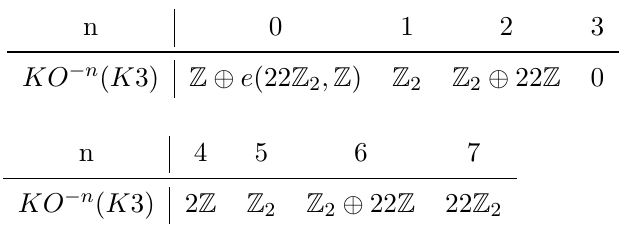
Table 19 . KO-groups KO − n ( K 3) , n = 0 , . . . , 7 , up to extensions. The result can be extrapolated to n ≥ 8 by Bott